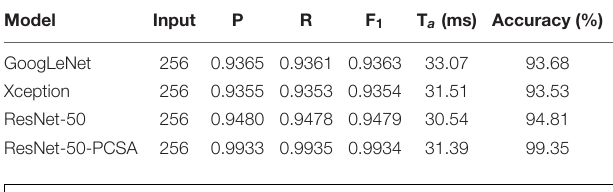
TABLE 7 | The evaluation result of the rice leaf dataset.